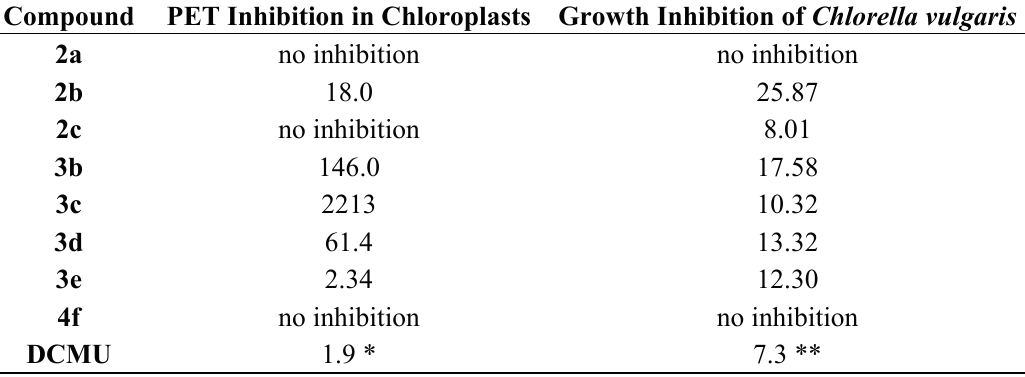
Table 1. IC 50 values ( μ mol/dm 3 ) of studied hydrazide and hydrazonoyl